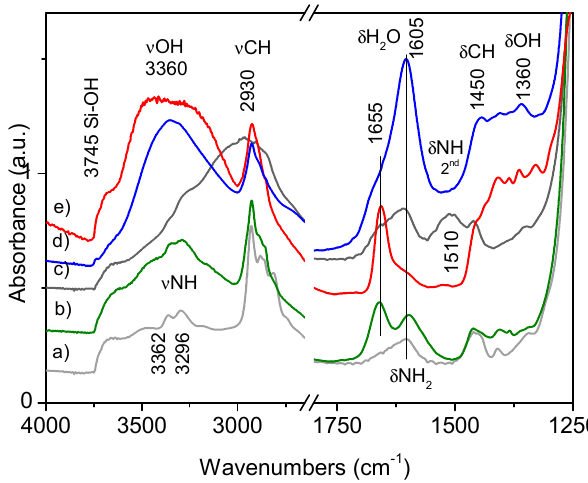
Figure 5. Infrared spectra of: ( a ) Si-diAm; ( b ) Si-diAm-CD-Cu; ( c ) Si-DETA; ( d ) Si-DETA-CD-Cu; ( e ) Si-NH-CD. All samples were outgassed at 80 °C before measurements.